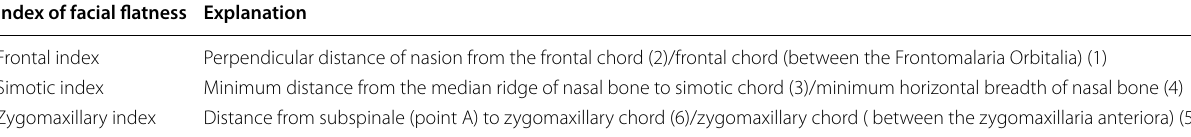
Table 3 Indices of facial flatness in anthropology (Chalala et al. 2019) Index of facial flatness